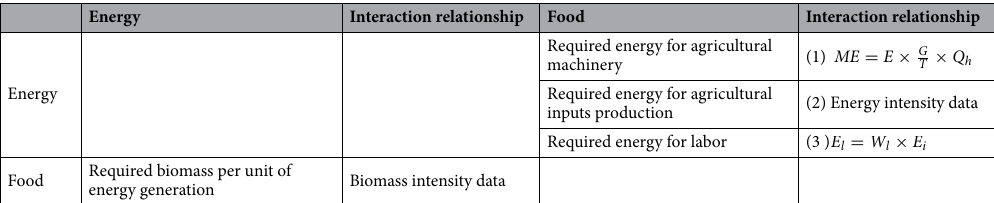
Table 2. Interactions among energy and food on the demand side with nexus approach. ME, machinery energy; E, production energy of the machine; G, weight of the machine; T, economic life of the machine; Q h , total working hours of the machine in a season; E l , human labor energy; W l , number of workers per hectare; E i , energy use per worker.